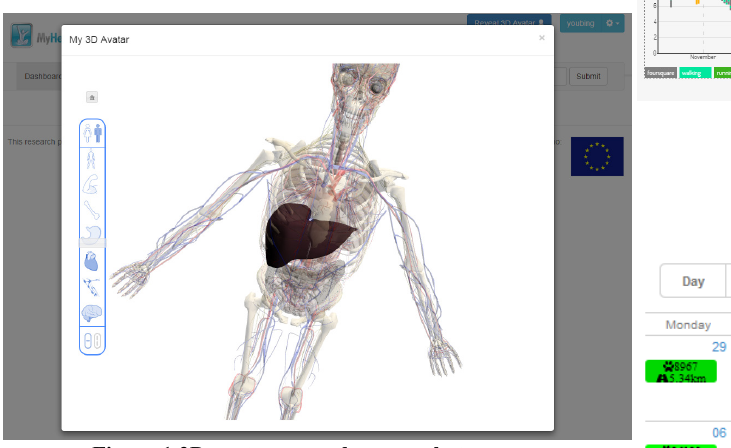
Figure 1 3D avatar example screenshot